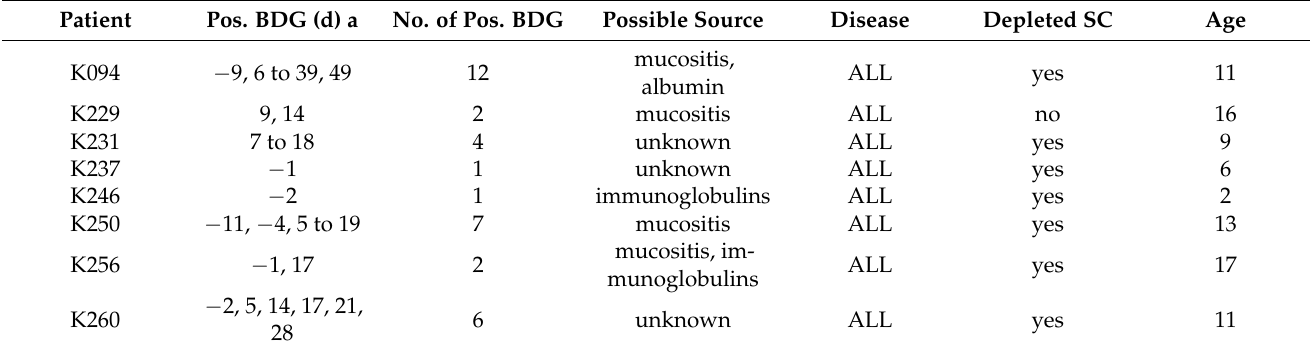
Table 5. Features of not classified patients with positive BDG testing. a: d, days in correlation to SCT; negative numbers indicate time before SCT. SC(T), stem cell (transplantation).